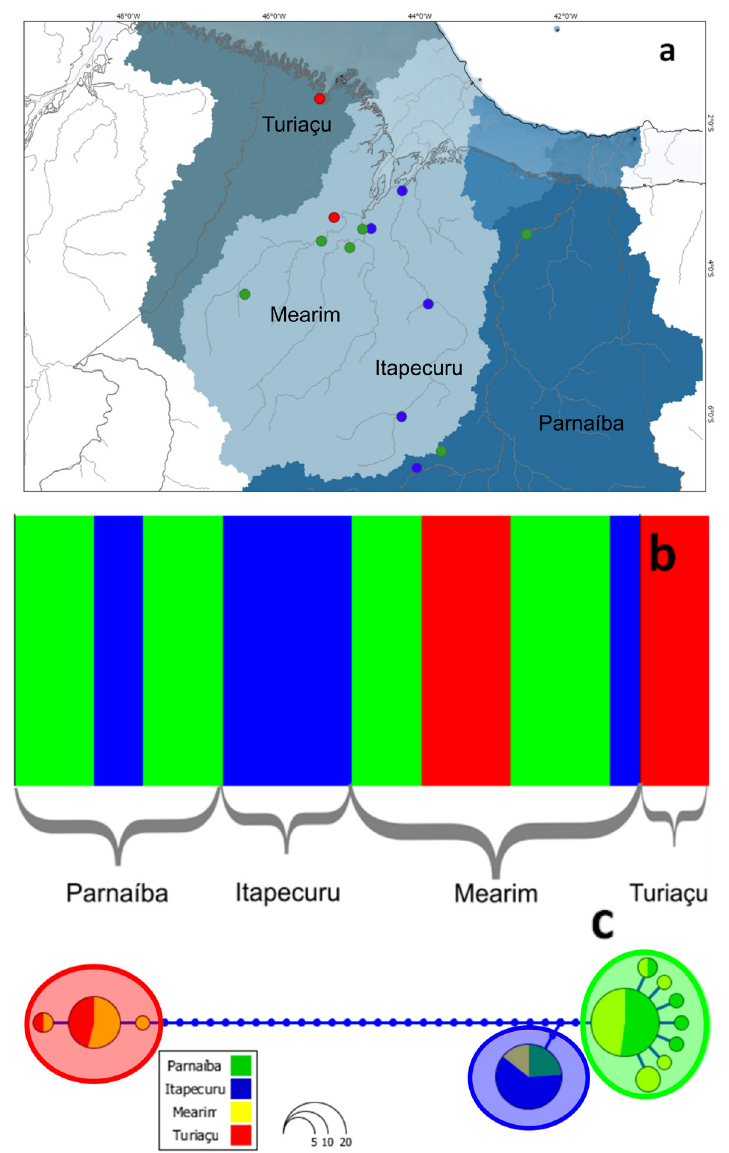
FIGURE 2 | Distribution and haplotype structure of Schizodon dissimilis. A. Paleodrainage reconstruction of coastal basins from northeastern Brazil and geographic distribution of groups defined by SAMOVA. B. Estimate of the probable groups of populations produced by the BAPS. C. Haplotypes network of cytochrome oxidase I ( coI ) . All analysis recovered a total of three groups in this area. The colors used to highlight areas in the network correspond to populations in